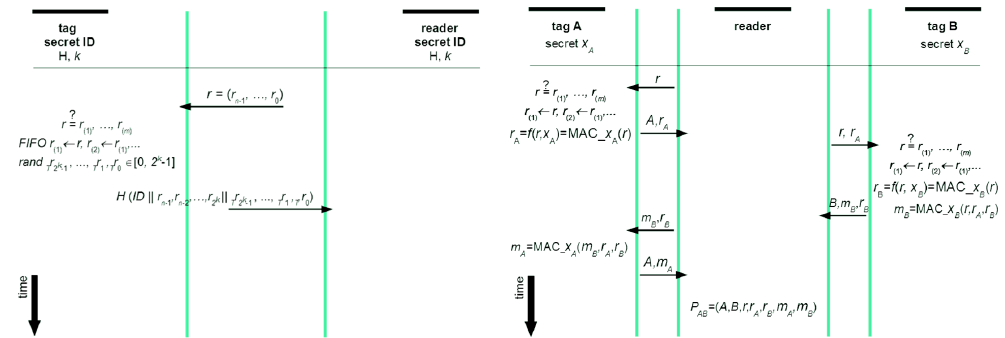
Figure 4. The ND-PEPS protocol ( Left ) and enhanced version of Juels/Piramuthu “Yoking proof” protocol ( Right ).